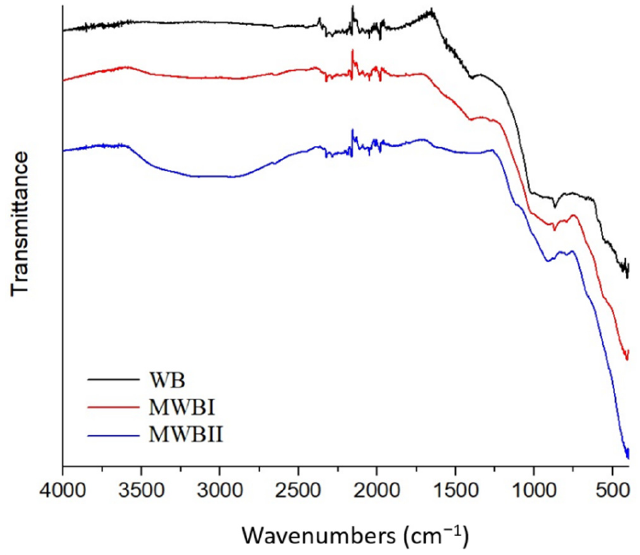
Figure 2. The FT-IR spectrum of WB, MWBI, and MWBII.